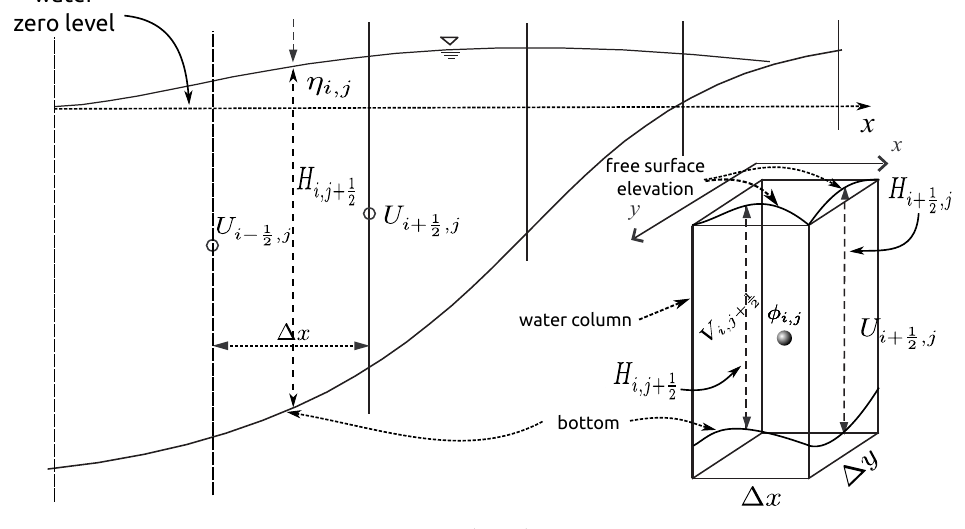
Figure A1. Vertical mesh